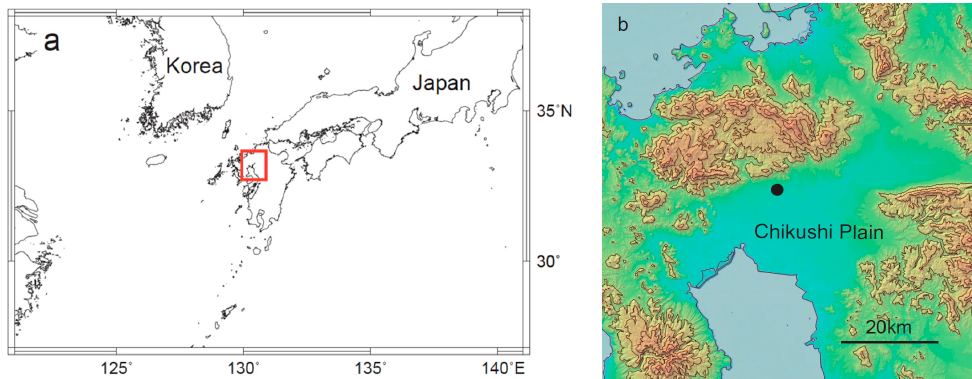
Figure 1. Study area. ( a ) Study area location and ( b ) zoomed-in contour map (100-m intervals) of the area outlined in ( a ). The black dot in ( b ) indicates the monitoring site (the contour map was generated